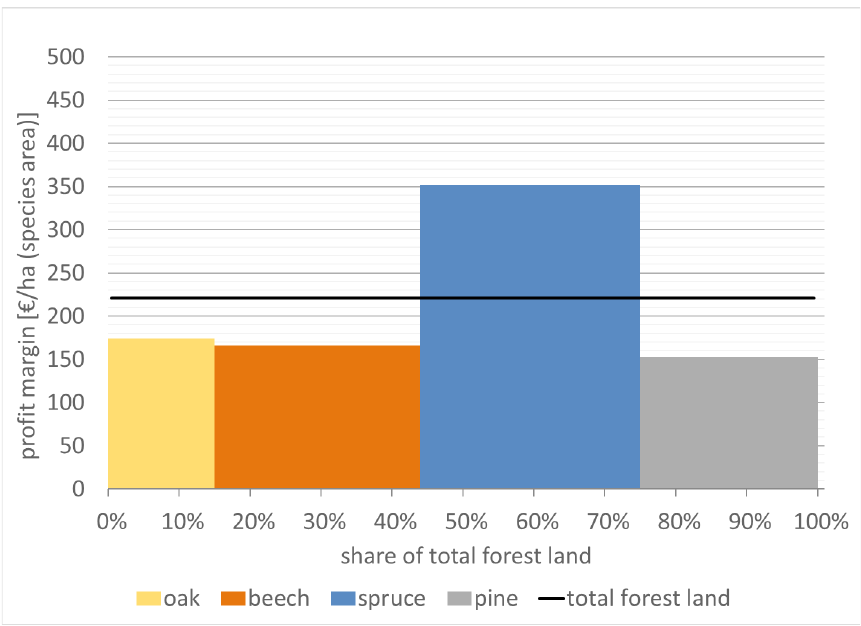
Figure 7: Profit margin per hectare according to main tree species (average